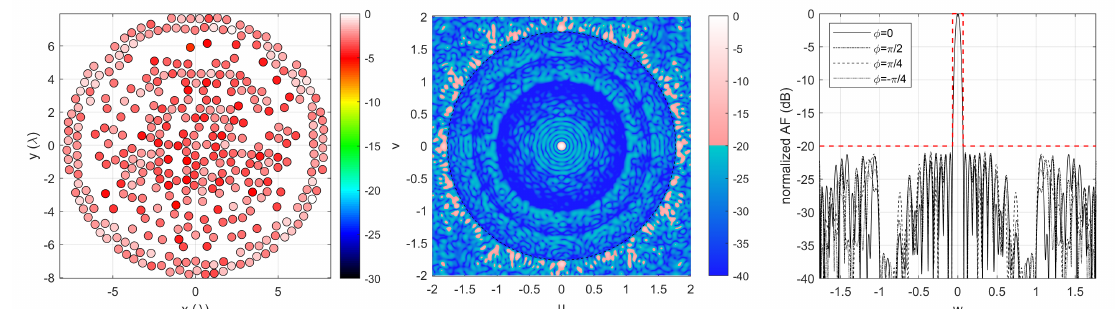
Figure 9. The 370 elements sparse layout. Left subplot: position and normalized excitation amplitude (dB) of the synthesized layout; center subplot: normalized Array Factor in the uv plane; right subplot: some relevant cuts. Negative values of w are related to the cuts φ (cid:48) = φ + π .